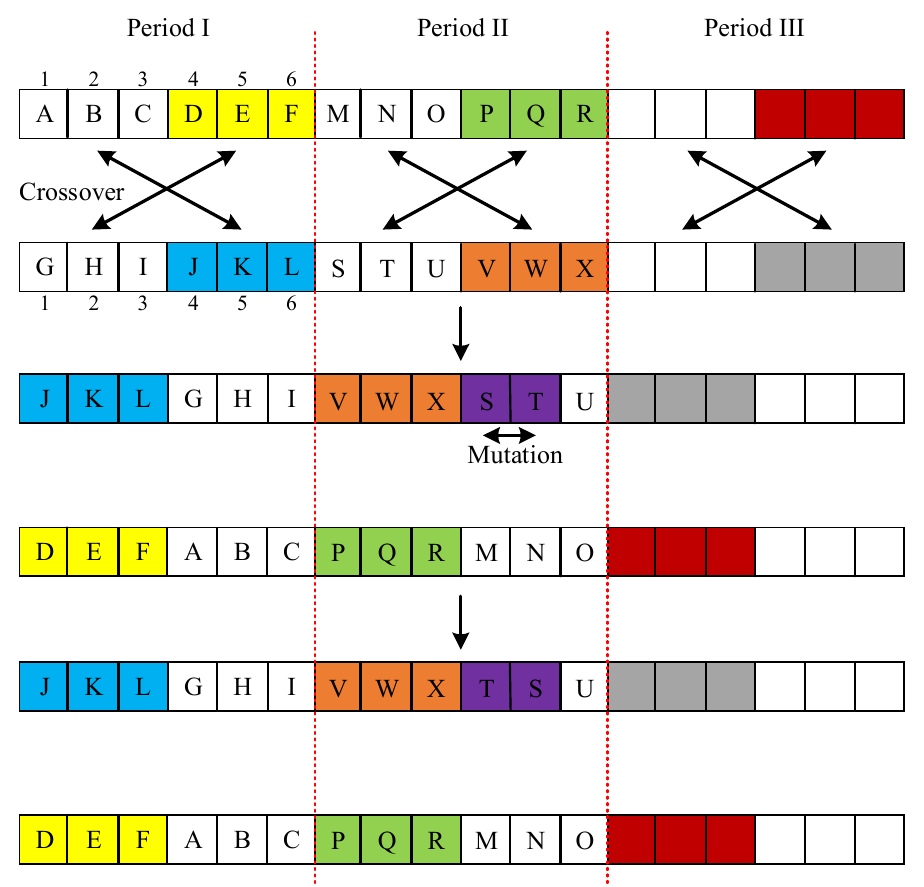
Figure 13. The schematic diagram of crossover and mutation.